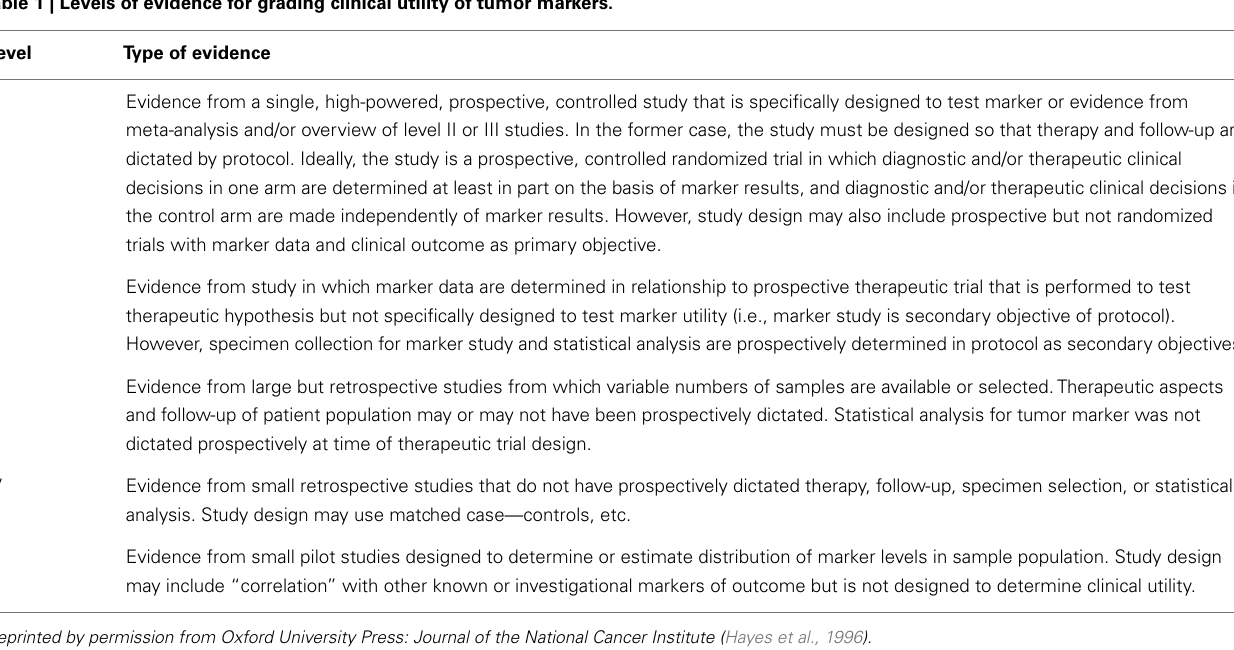
Table 1 | Levels of evidence for grading clinical utility of tumor